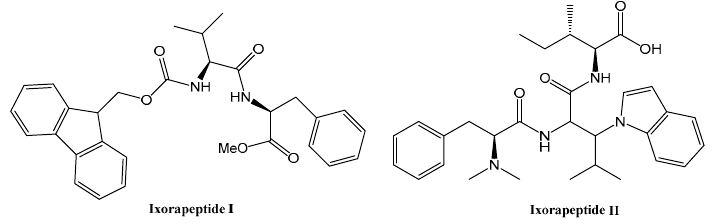
Figure 12. Structures of Ixorapeptide I and Ixorapeptide II.